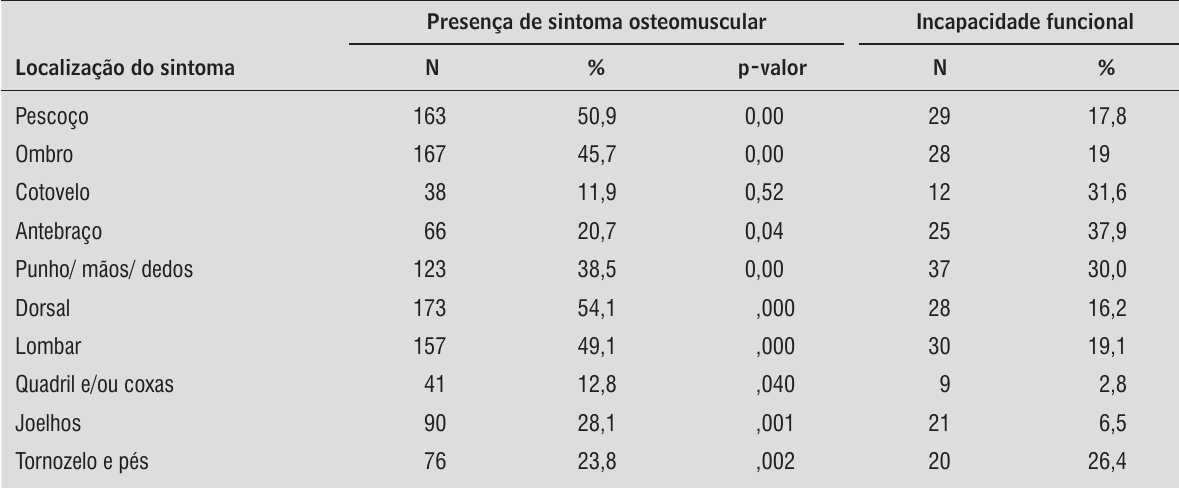
Tabela 2 - Prevalência de sintomas osteomusculares em relação às condições ergonômicas do trabalho apresentadas nas escolas públicas e privadas (p = 0,003)